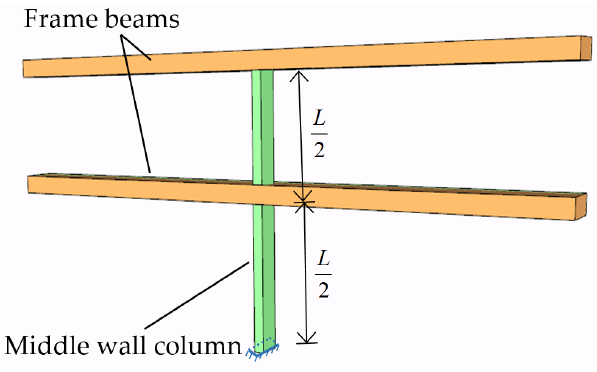
Figure 5. The middle wall column of the hole.